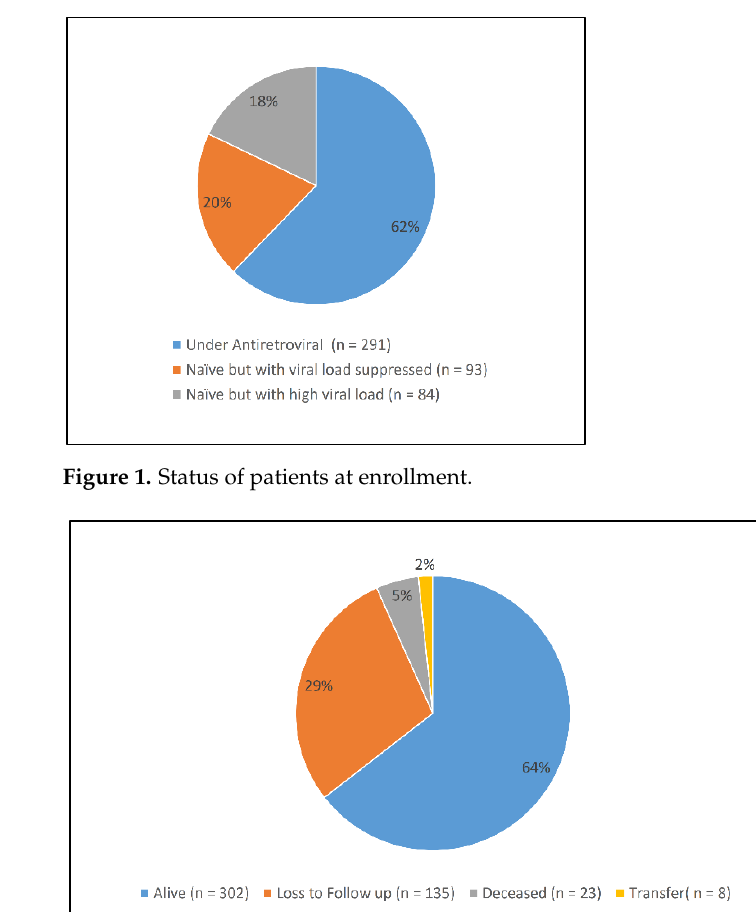
Figure 2. Status of patients at the end of the study.